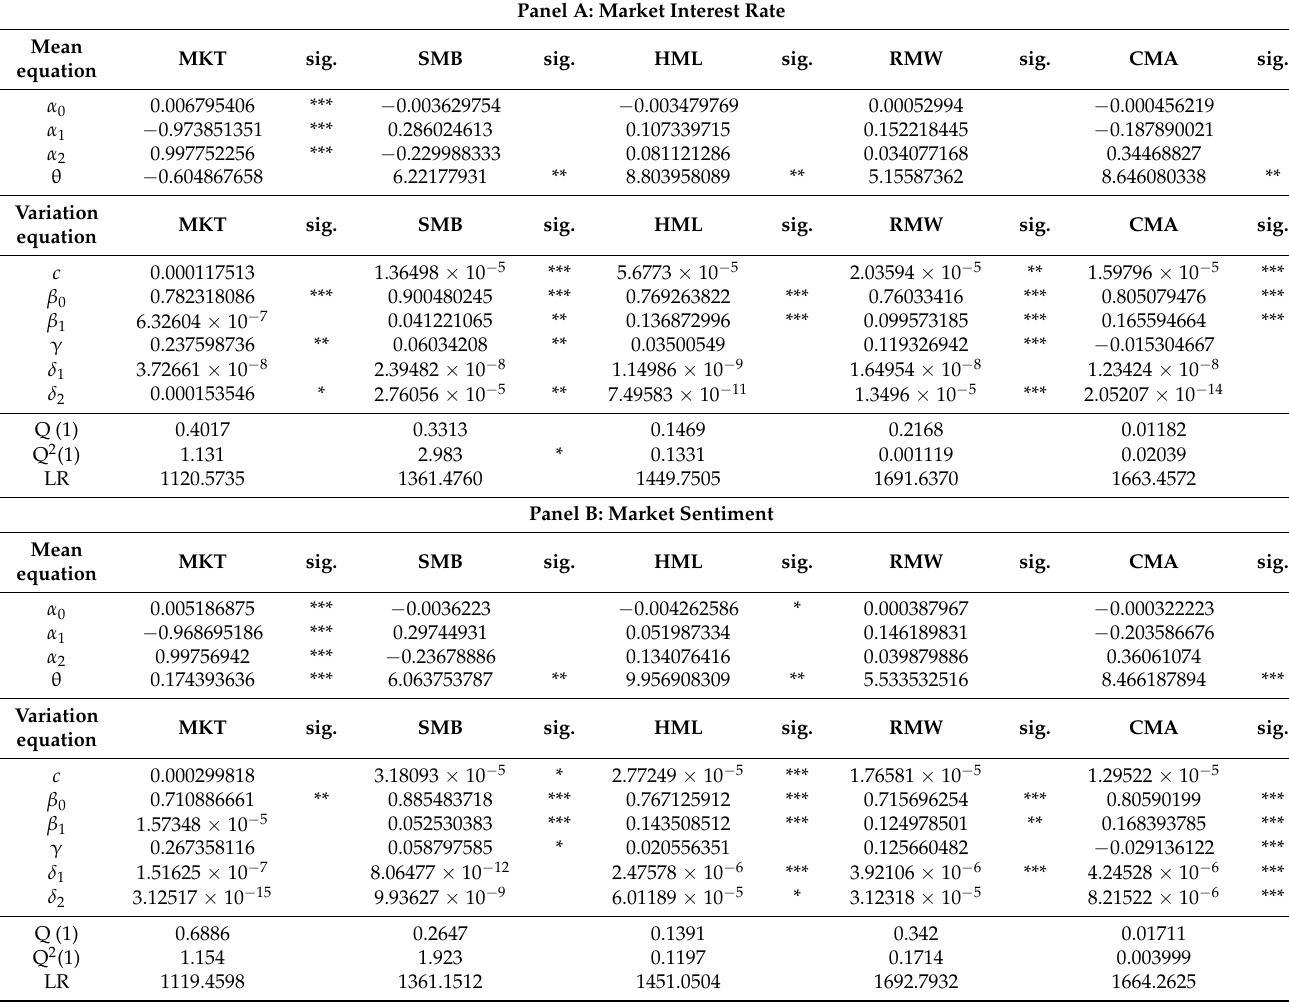
Table 2. Results of the GJR-GARCH(1,1)-M model on five-factor returns. The empirical setting is ARMA(1,1) effect prior to performing the GJR-GARCH(1,1)-M model. Q and Q-squared values indicate Ljung–Box Q statistics, which verify the autocorrelation of residuals and squared residuals of the model. LR represents the statistics of the likelihood ratio, and sig. denotes significance level. MKT, SMB, HML, RMW, and CMA denote the monthly return of the market, size, value, profitability, and investment factors, respectively. The sample period spans from July 1965 to December